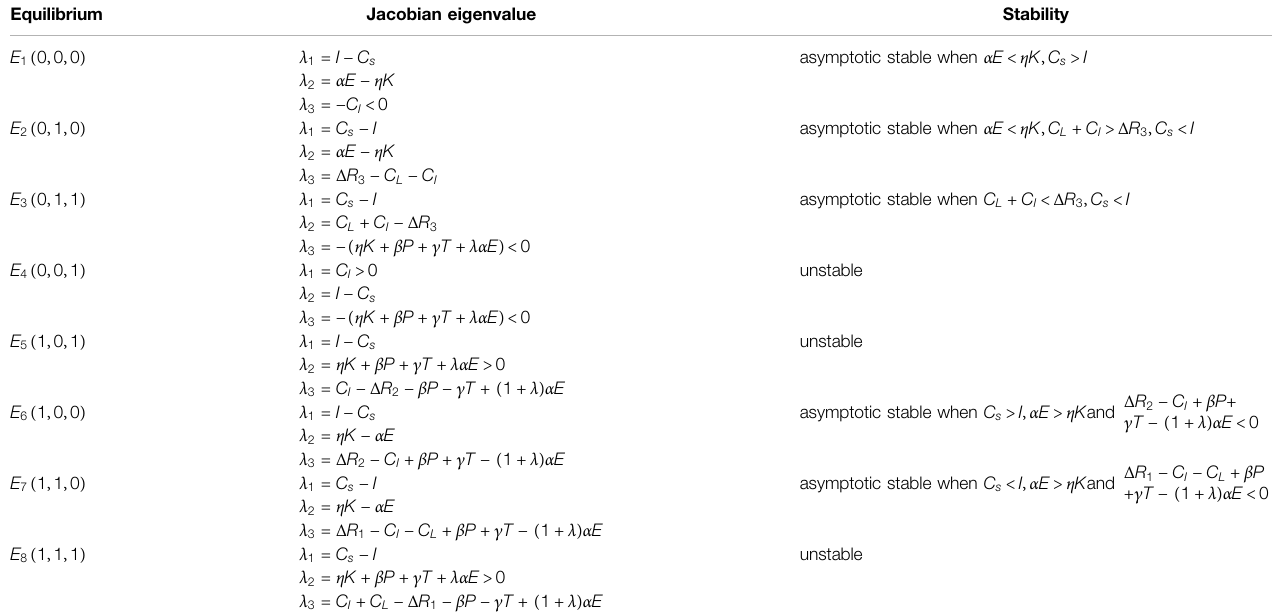
TABLE 3 | Result of local Stability. Equilibrium Jacobian eigenvalue Stability